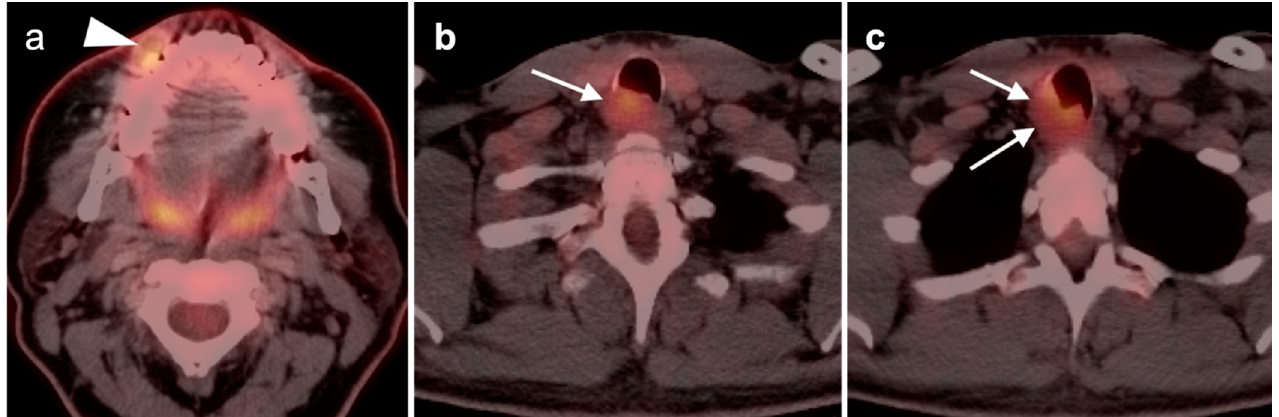
Figure 29. Adenoid cystic carcinomas (ACC). ( a ) ACC of the buccal surface is mildly hypermetabolic on FDG PET ‐ CT (white arrowhead). ( b , c ) ACC of the trachea is also relatively mild in metabolic activity (white arrows).